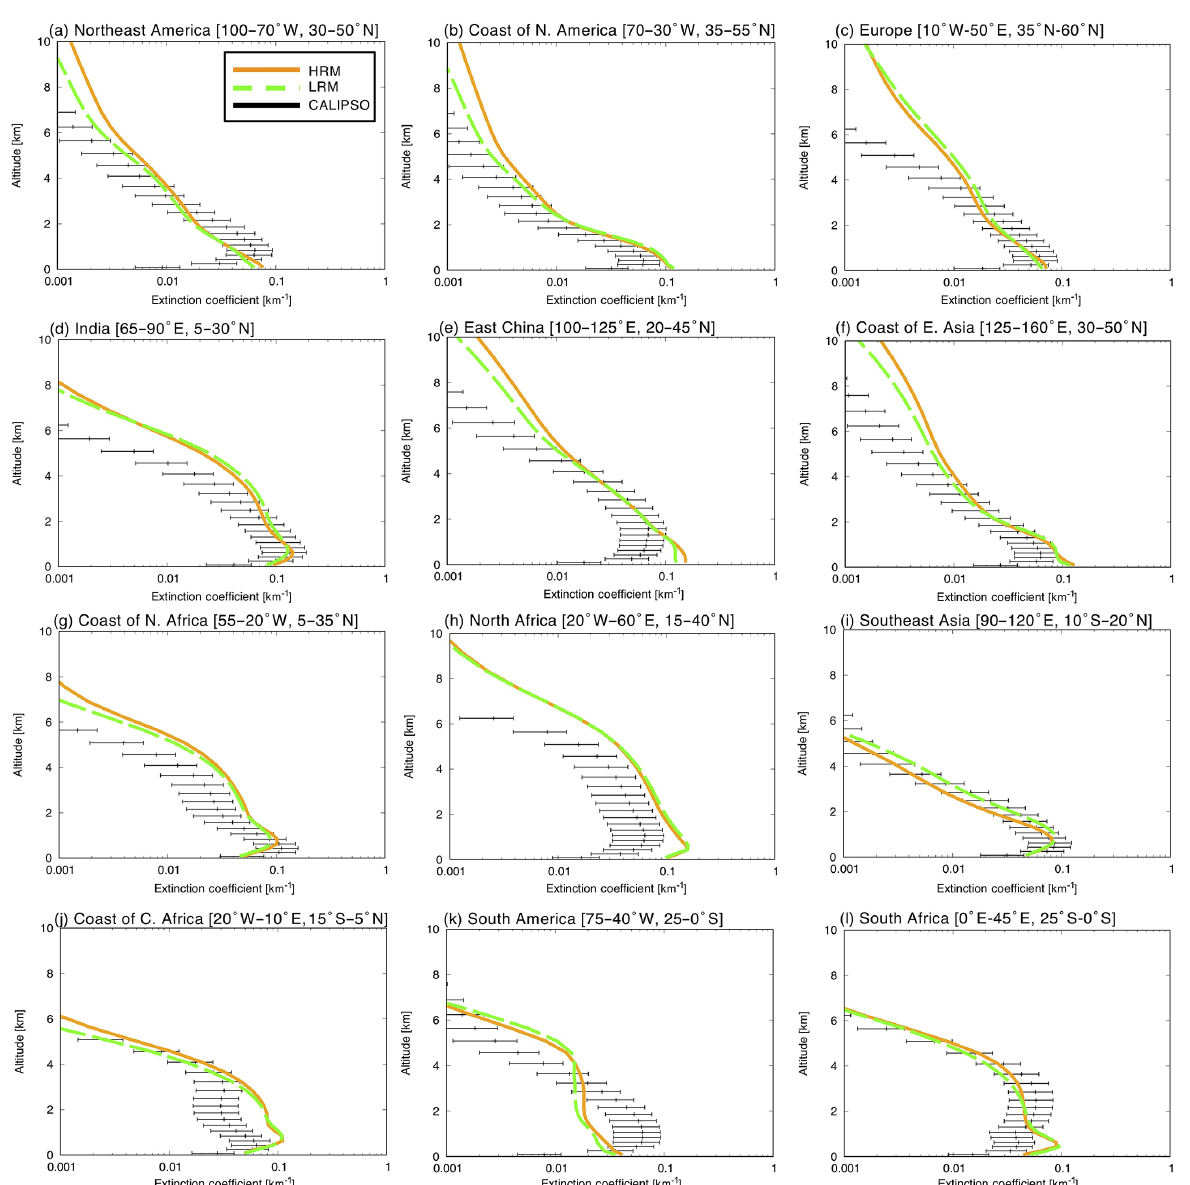
Figure 13. Vertical distributions of the annually averaged aerosol extinction coefficients from the NICAM simulations (HRM in orange and LRM in green) and from CALIOP/CALIPSO observations (black) in 12 different regions. The definition of the region is based on Koffi et al. (2016) except for (i) southeast Asia and (j) the coast of central Africa. The CALIOP-retrieved results are shown as bars, which are the standard deviation of the results from a 3-year integration